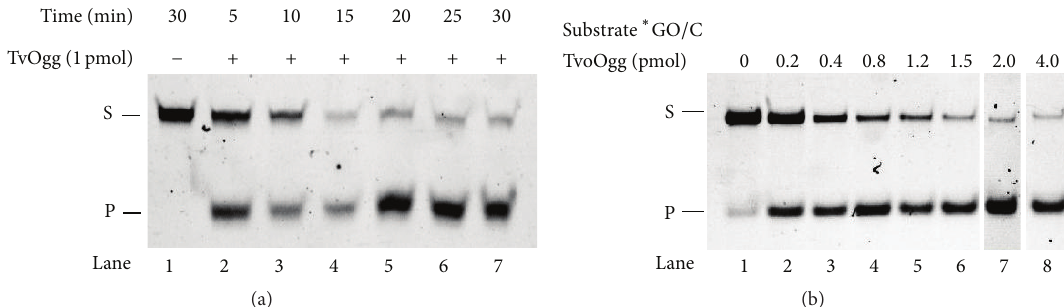
Figure 4: GO glycosylase/lyase activity assay of putative TvoOgg. (a) Time course of TvoOgg glycosylase activity on substrate ∗ GO / C. 34-bp heteroduplex DNA containing a ∗ GO / C mismatch was incubated with (lanes 2 to 7) or without (lane 1) 1 pmol of TvoOgg. The uncut 34- mer DNA substrate (S) and cleaved 13-mer product (P) are indicated on the left. (b) Dose dependency of ∗ GO / C mismatch-specific DNA glycosylase activity of TvoOgg on 34-bp double-stranded DNA containing GO/C. The uncut 34-mer DNA substrates (S) and cleaved 13-mer products (P) are indicated on the left. Asterisk indicated the 5 󸀠 FAM-labeled strand.